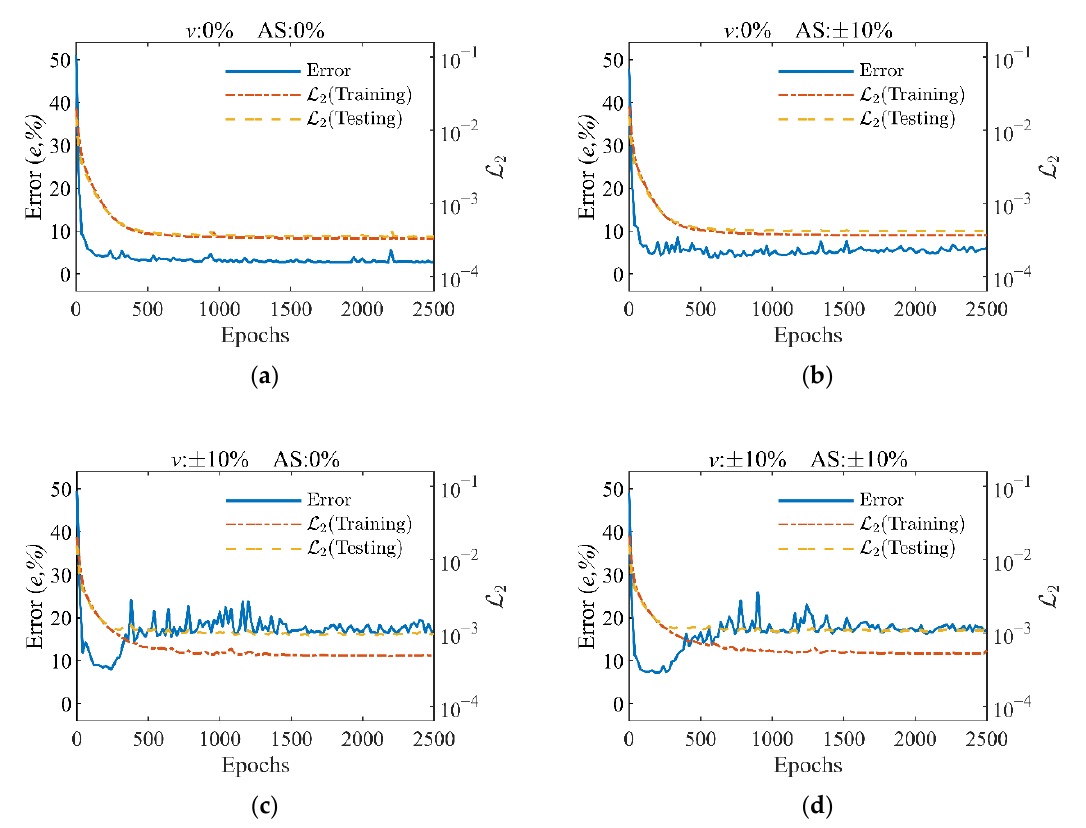
Figure 13. Time history curve of loss function and error during training: ( a ) no error in training data; ( b ) no error in training data of speed and given error in training data of axle spacing ranging from − 10% to + 10%; ( c ) given error in training data error of speed ranging from − 10% to +10% and no error in training data of axle spacing; ( d ) given error in training data of speed ranging from − 10% to +10% and given error in training data of axle spacing ranging from − 10% to +10%. v , the level of error in training data of speed; AS, the level of error in training data of axle spacing.